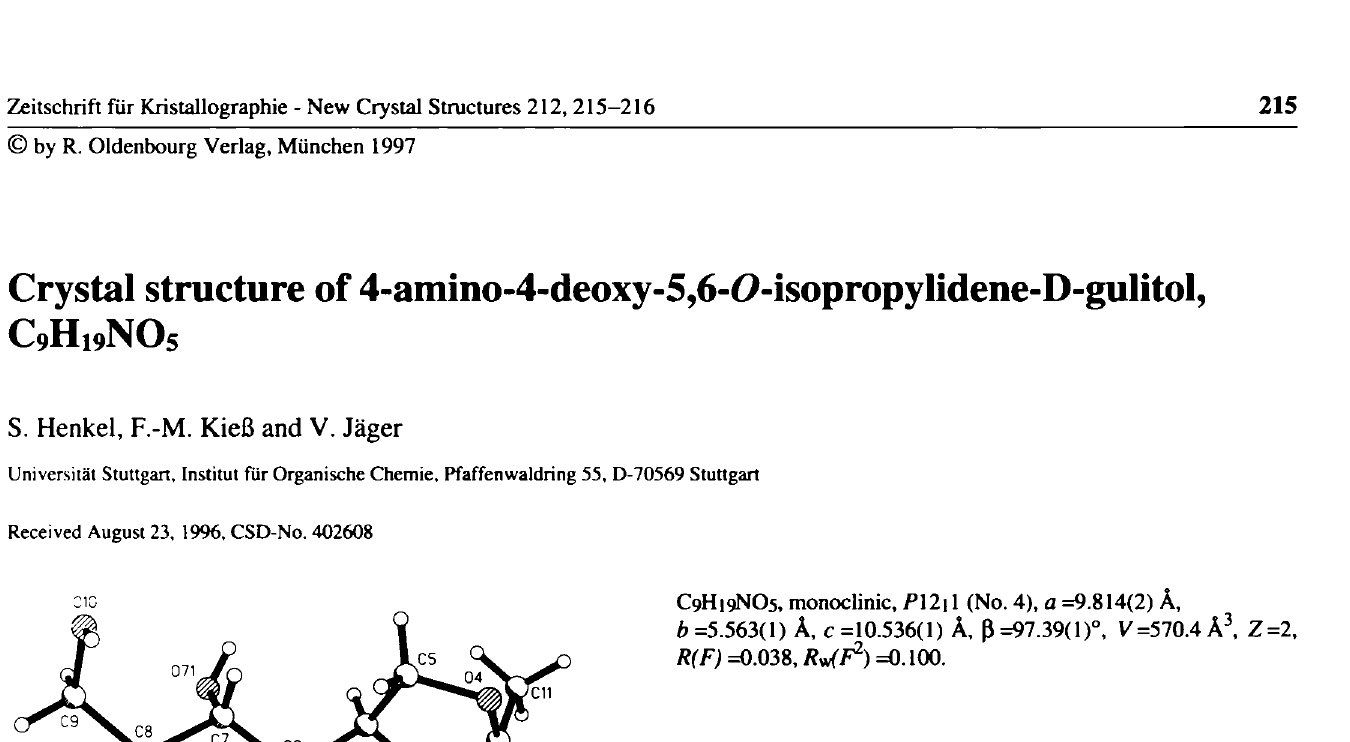
Table 2. Final atomic coordinates and displacement parameters (in A 2 )